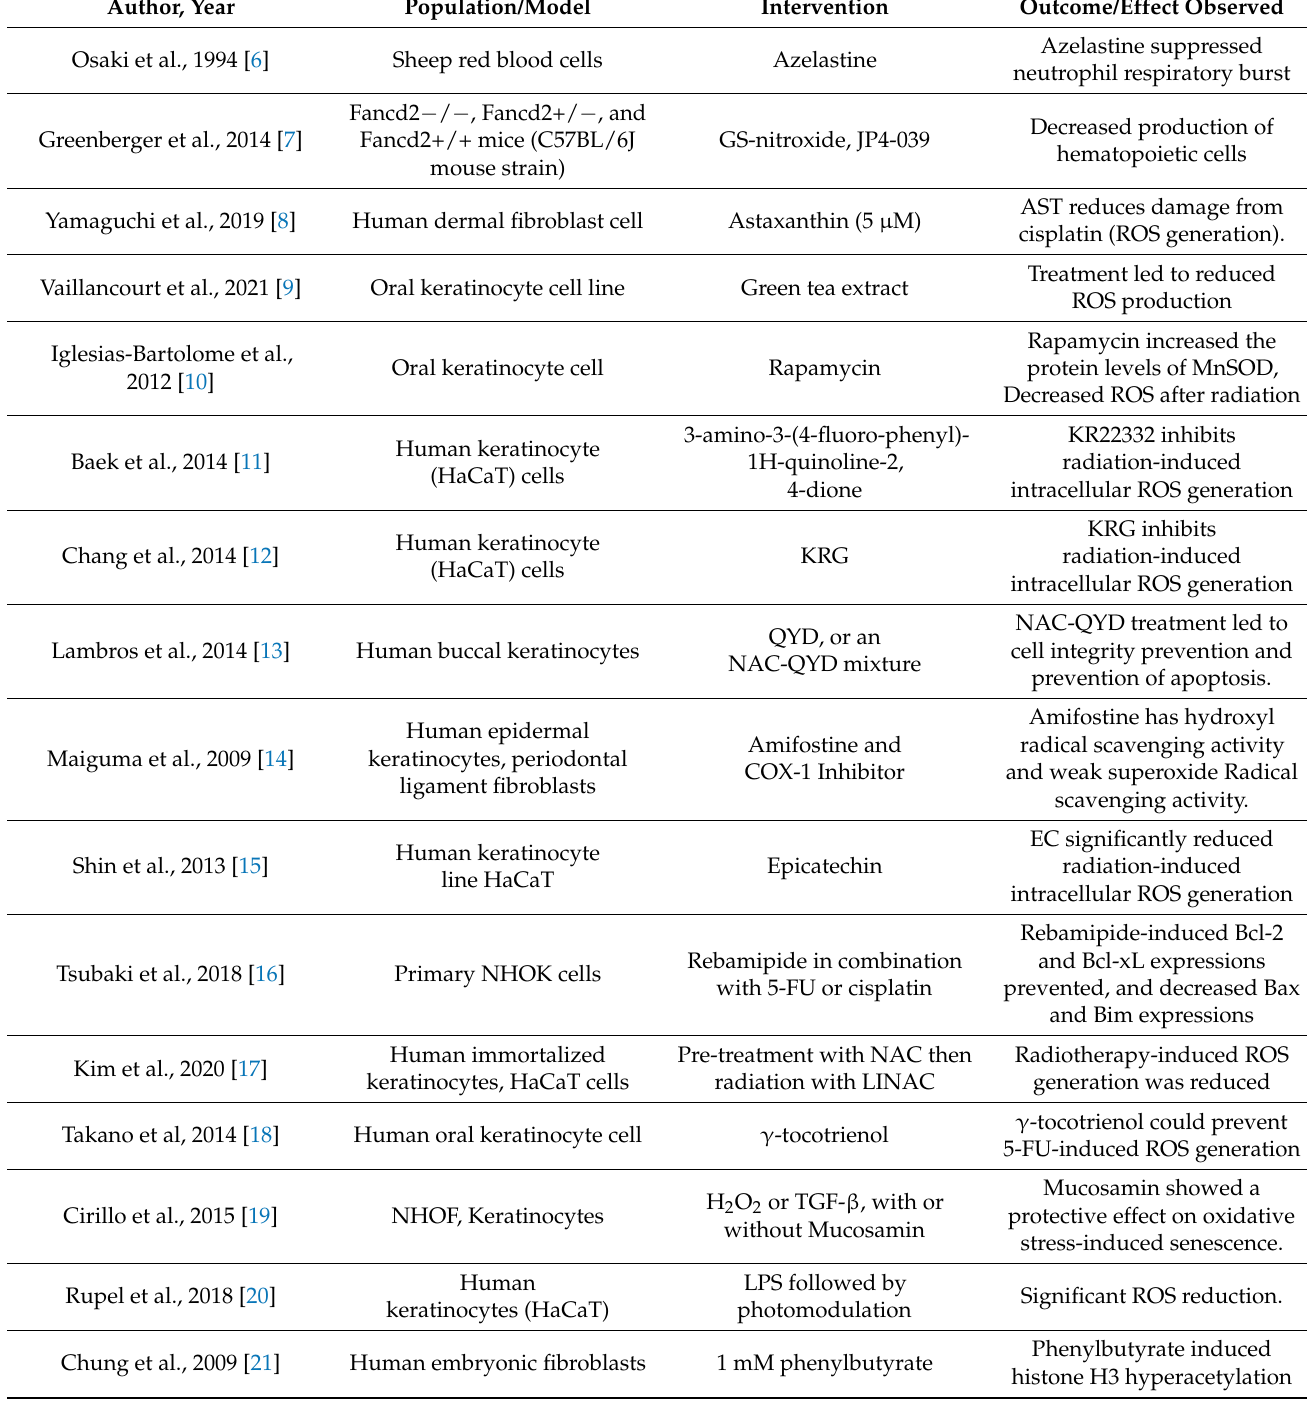
Table 1. Summary of in vitro study designs and